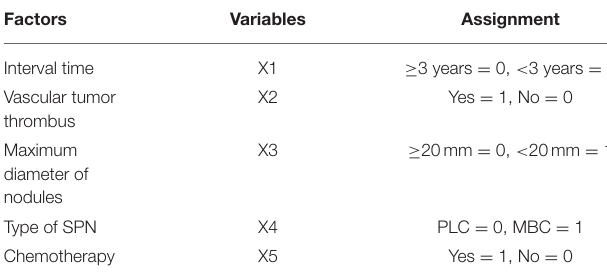
TABLE 4 | Assignment for multivariate analysis of